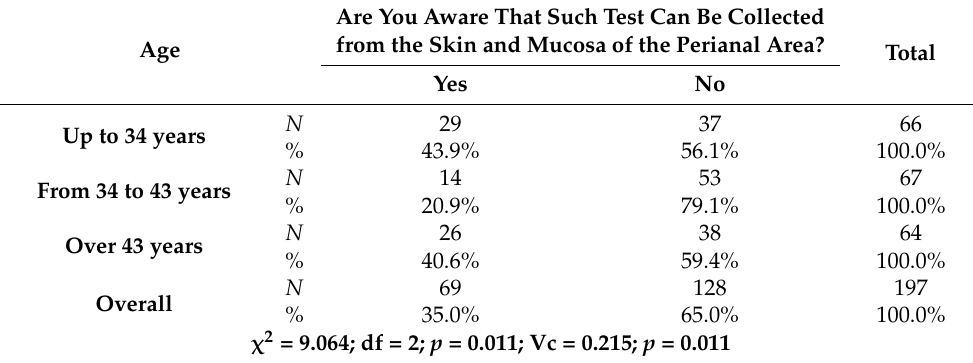
Table 6. Relationship between the age of the respondents and the awareness that the HPV test can be performed from samples collected from the skin and mucosa of the perianal area. Are You Aware That Such Test Can Be Collected from the Skin and Mucosa of the Perianal Area? Total Age Yes No N 29 37 66 Up to 34 years % 43.9% 56.1% 100.0% N 14 53 67 From 34 to 43 years % 20.9% 79.1% 100.0% N 26 38 64 Over 43 years % 40.6% 59.4% 100.0% N 69 128 197 Overall % 35.0% 65.0%